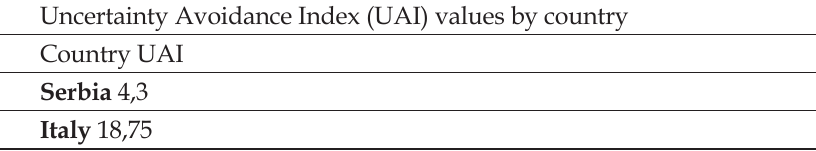
Table 3. Uncertainty Avoidance Index (UAI) values by